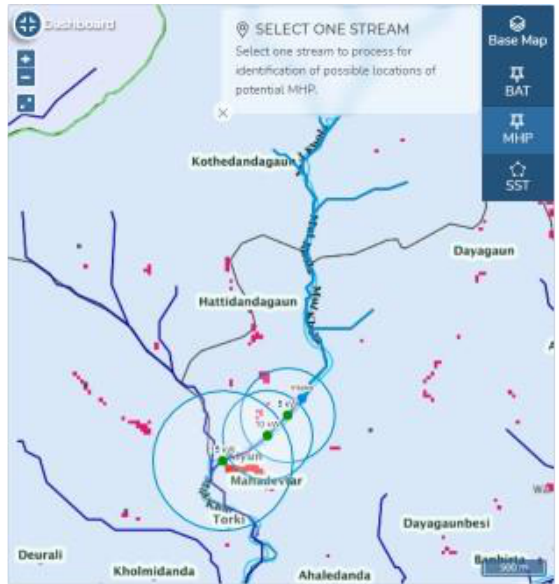
Figure 6. Exploring micro-hydropower (river creek line: blue; intake point: blue; circle: MHP locations: green dots; and catchment area: circular in blue).